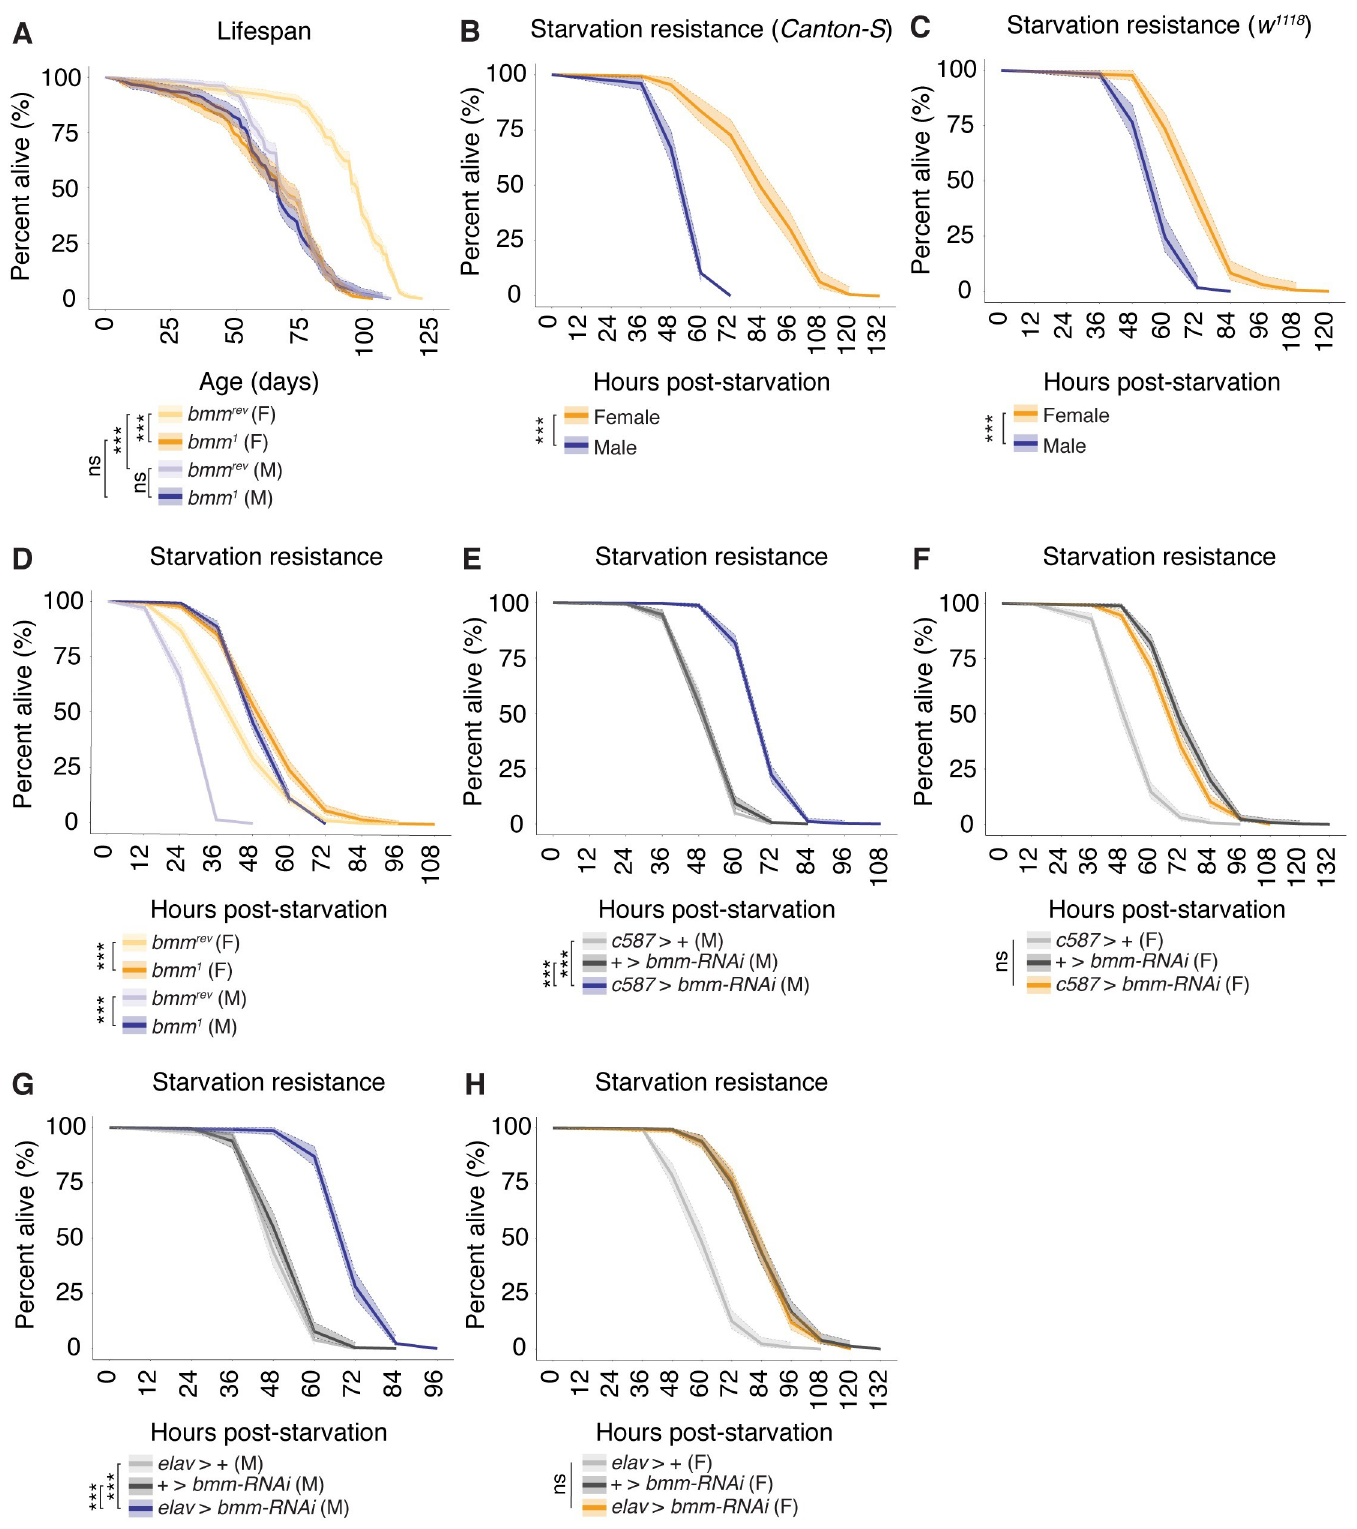
Fig 7. bmm -mediated regulation of triglyceride homeostasis affects life span and contributes to the sex difference in starvation resistance. (A) Median life span was significantly higher in bmm rev virgin females than in bmm rev virgin males ( p = 2 × 10 − 16 ; Log-rank test with Bonferroni correction for multiple comparisons; n > 297 for